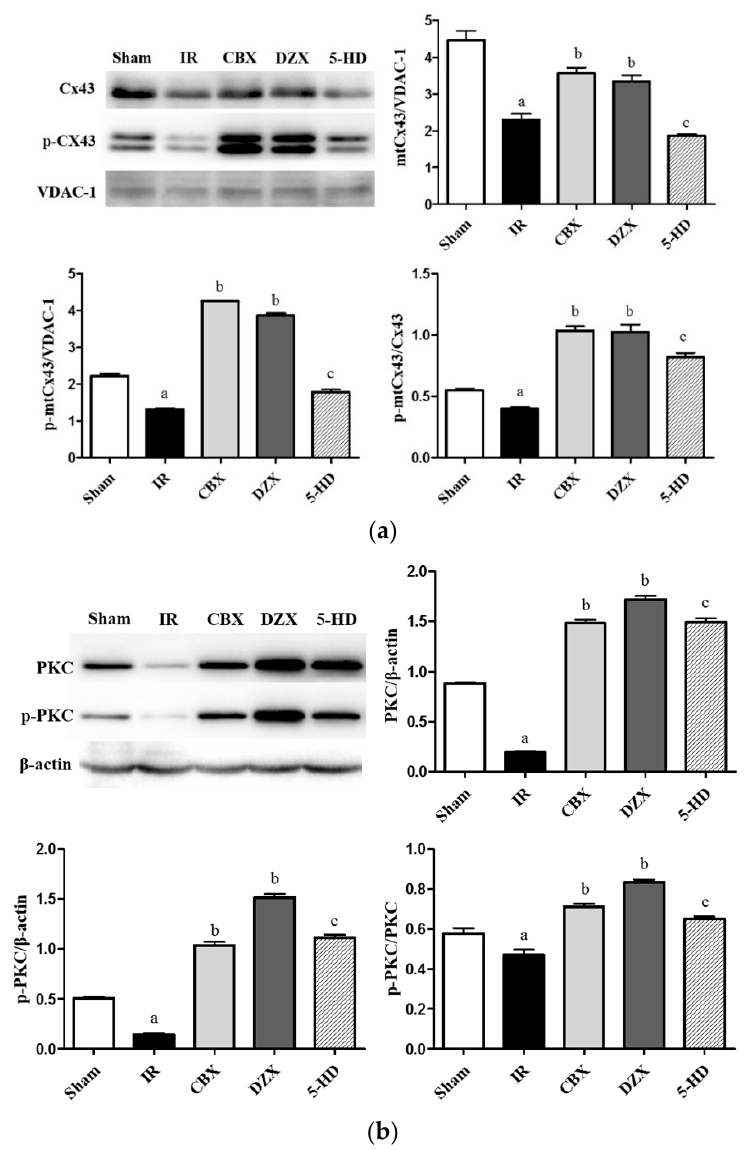
Figure 6. Effects of interference with the mitoKATP channel on the expression of mtCx43, p-mtCx43, protein kinase C epsilon (PKC ε ), and p-PKC ε in the rat cerebral cortex after ischemia-reperfusion injury. ( a ) The expression of mtCx43 and p-mtCx43 in different groups. F (mtCx43) = 46.68, p ≤ 0.05; F (p-mtCx43) = 46.68, p ≤ 0.05; F (p-mtCx43/Cx43) = 46.68, p ≤ 0.05; a p ≤ 0.05 vs. Sham; b p ≤ 0.05 vs. IR; c p ≤ 0.05 vs. DZX; ( b ) The expression of PKC ε and p-PKC ε in different groups. Data are presented as mean ± standard deviation, n = 6 in each group. F (PKC ε ) = 470.3, p ≤ 0.05; F (p-PKC ε ) = 966.4, p ≤ 0.05; F (p-PKC ε /PKC ε ) = 101.9, p ≤ 0.05; a p ≤ 0.05 vs. Sham; b p ≤ 0.05 vs. IR; c p ≤ 0.05 vs. DZX.